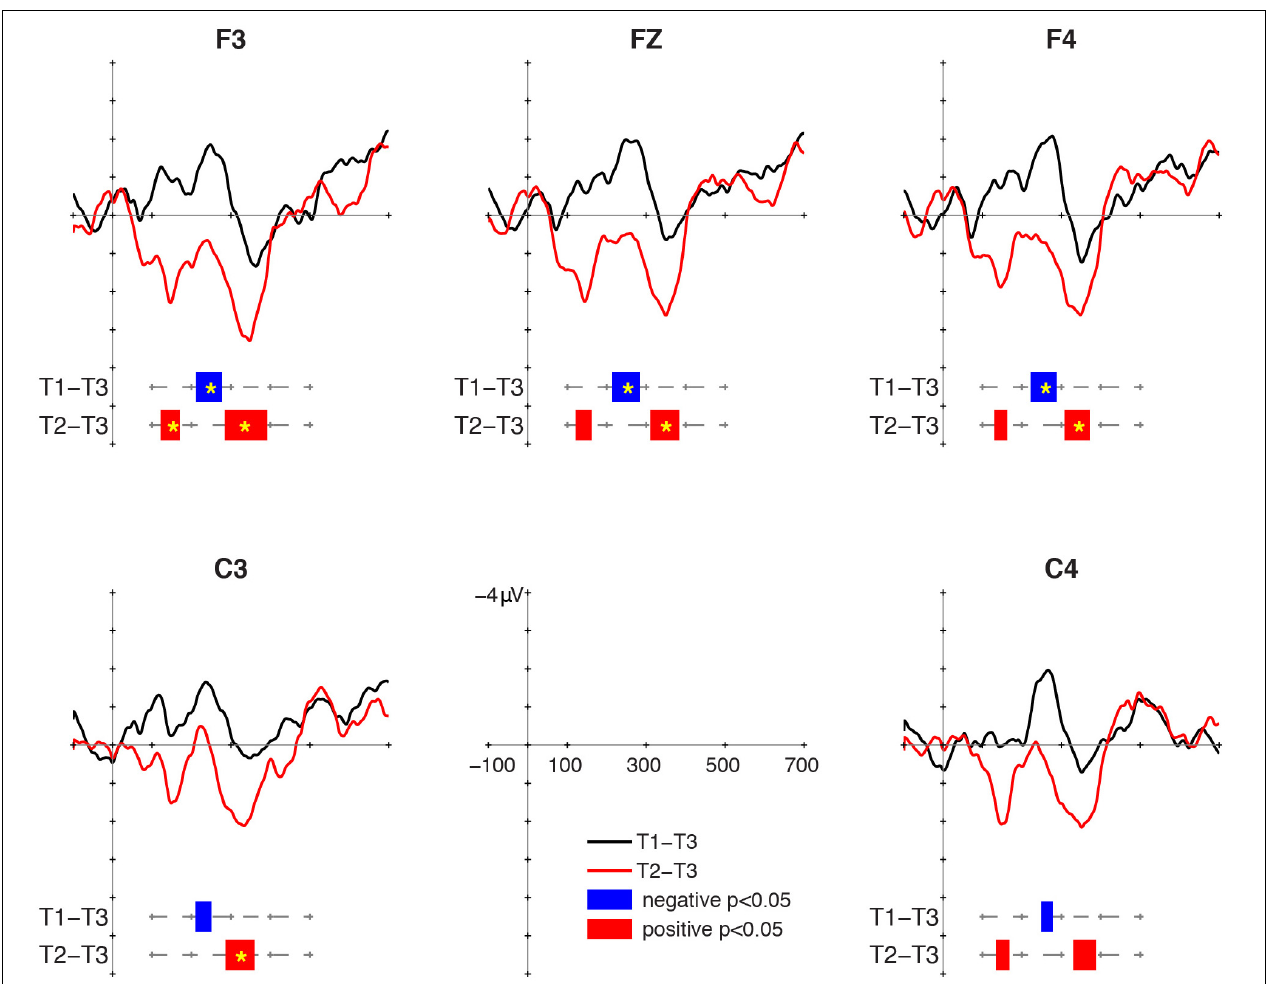
FIGURE 2 | Mismatch responses (MMRs) at 18 months of